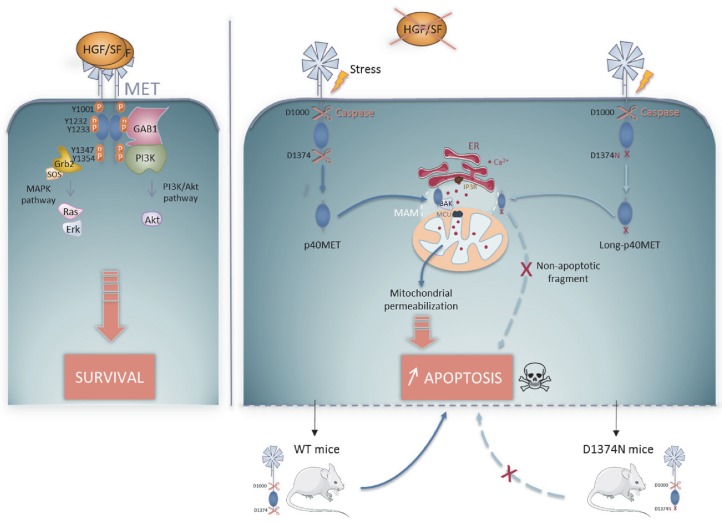
Schematic representation of the MET pro-survival and pro-apoptotic pathways in the presence of HGF/SF, MET receptor dimerizes and activates pro-survival signaling by activating the MAPK and PI3K/AKT pathways.In the absence of ligand, MET is cleaved by caspase 3 at a juxtamembrane and a C-terminal site to generate the p40MET fragment, which translocates to the MAM microdomain. p40MET may interact with BAK and promote deregulation of the Ca2+ flux between the ER and the mitochondria, causing mitochondrial permeabilization involved in amplification of apoptosis. This dual role of MET classifies it as a dependence receptor. D1374N MET, mutated at the C-terminal caspase site, generates a slightly longer fragment that can no longer promote apoptosis. Upon stress induction by FAS activation in WT and D1374N mice, D1374N hepatocytes show less apoptosis. This suggests that C-terminal caspase cleavage of MET is important for optimal apoptosis in vivo.